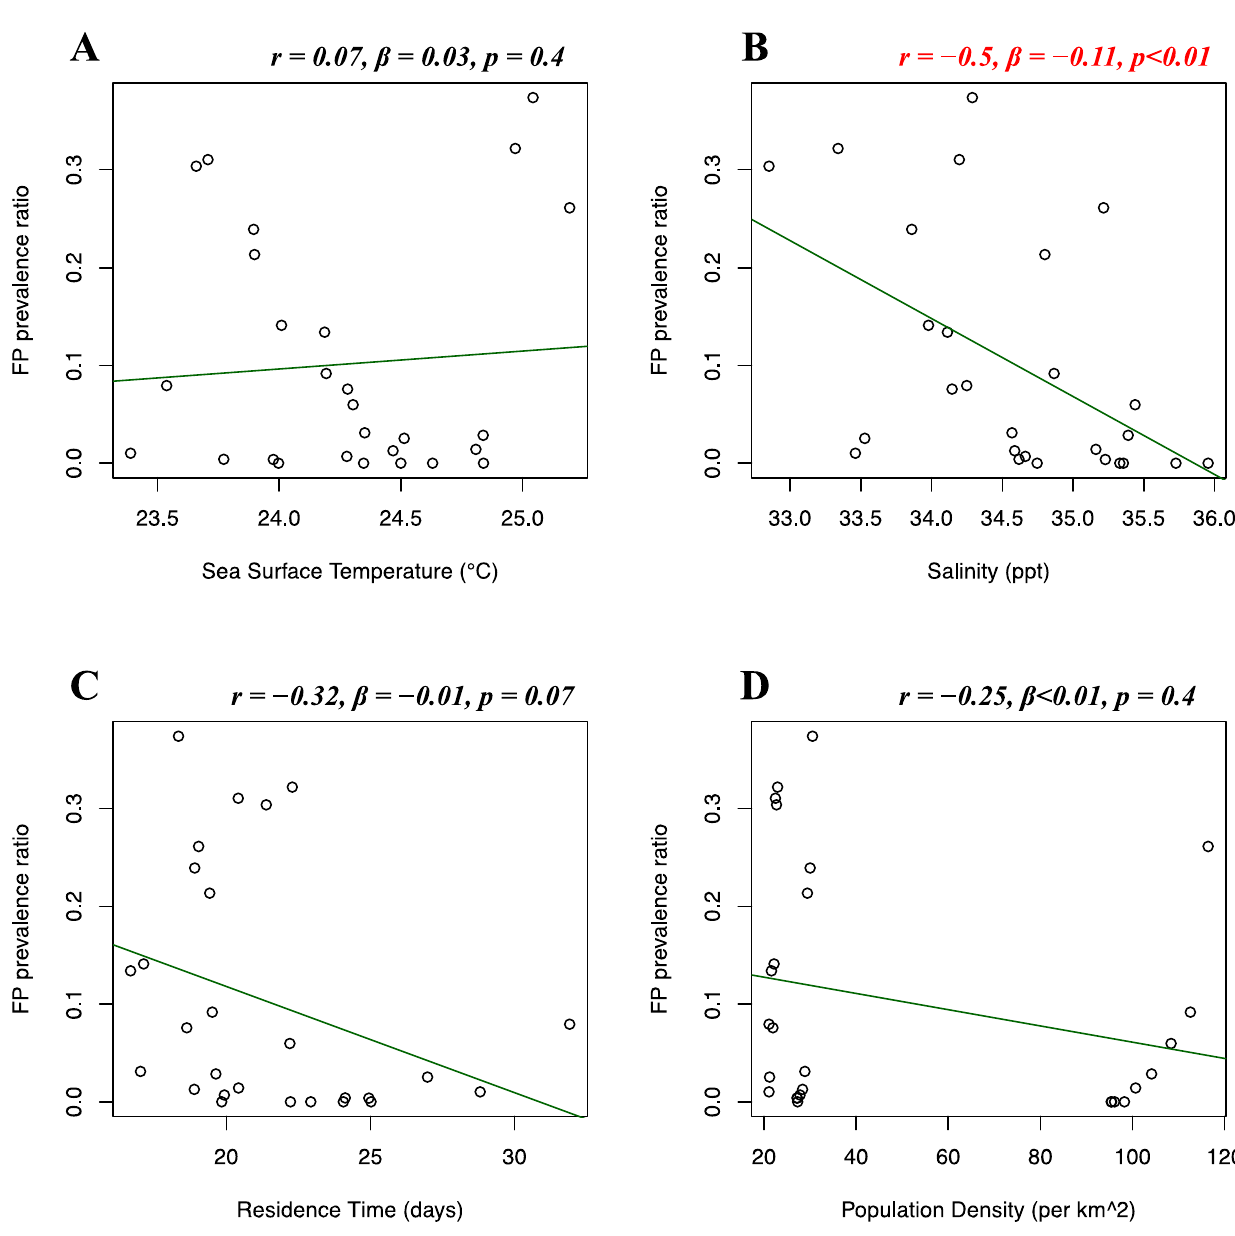
Figure 8. Texas FP prevalence and environmental and demographic variables. Scatterplots with fitted regression lines representing the logistic regression output from the response variables versus predictor variables in the Texas dataset. Subplots show FP prevalence ratio on the y -axis versus sea surface temperature ( A ), salinity ( B ), residence time ( C ), and population density ( D ) on the x -axis. Pearson correlation ( r ), beta-coefficient ( β ), and p -value ( p ) are reported for each predictor variable on the top right of the respective plot. Significant relationships are highlighted in red.